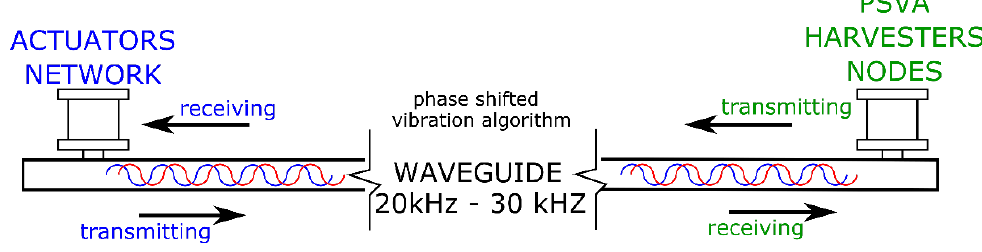
Figure 5. Power transmission through ultrasonic vibration — scheme.